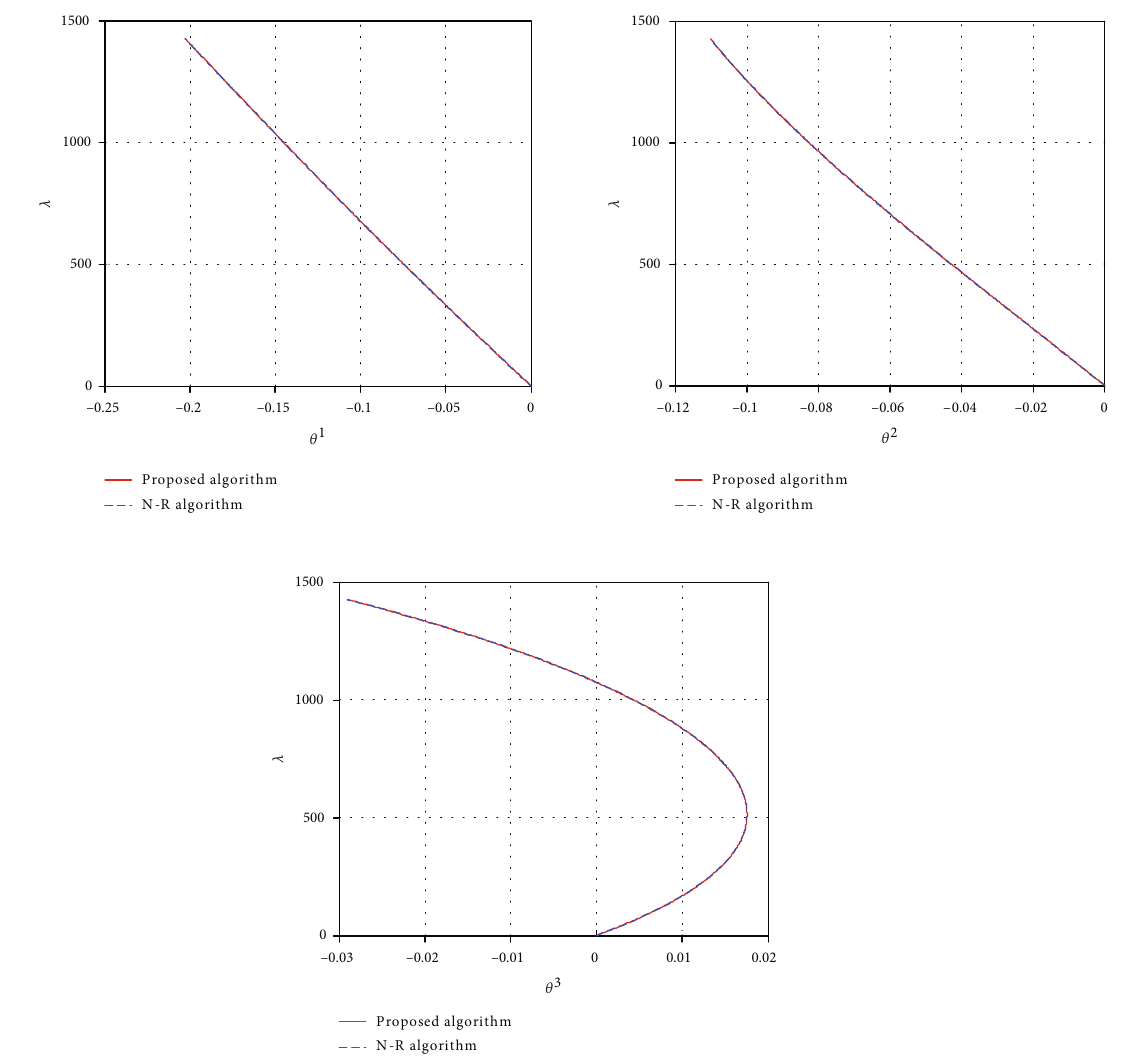
Figure 8: Load-rotation curves obtained by both algorithms.